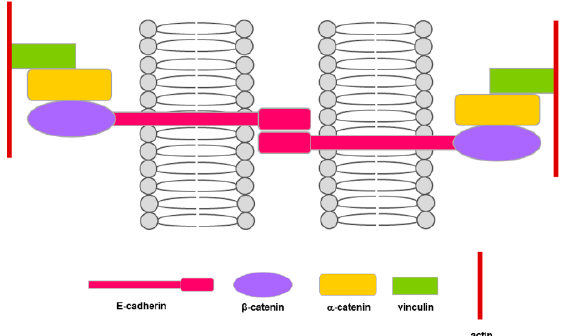
Figure 3. Schematic representation of E-cadherin and its relationship with the components forming adherens junctions. The extracellular domain of the E-cadherin transmembrane proteins mediates the cell–cell anchoring, while its cytoplasmic domain interacts with proteins that bridge E-cadherin with the supporting microfilaments.